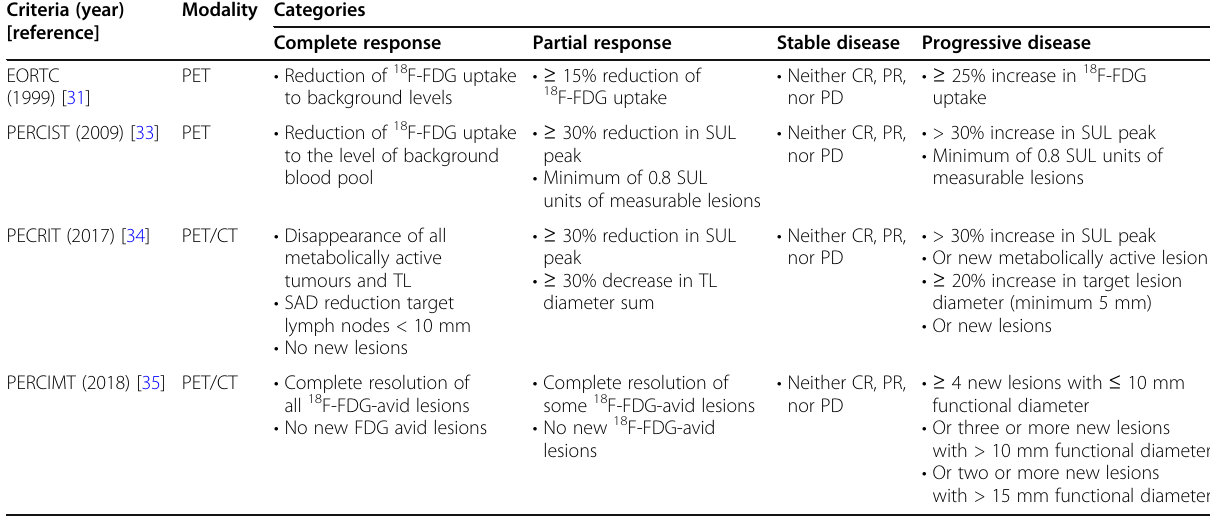
Table 2 Overview metabolic and combined response evaluation to immunotherapy Criteria (year) [reference]